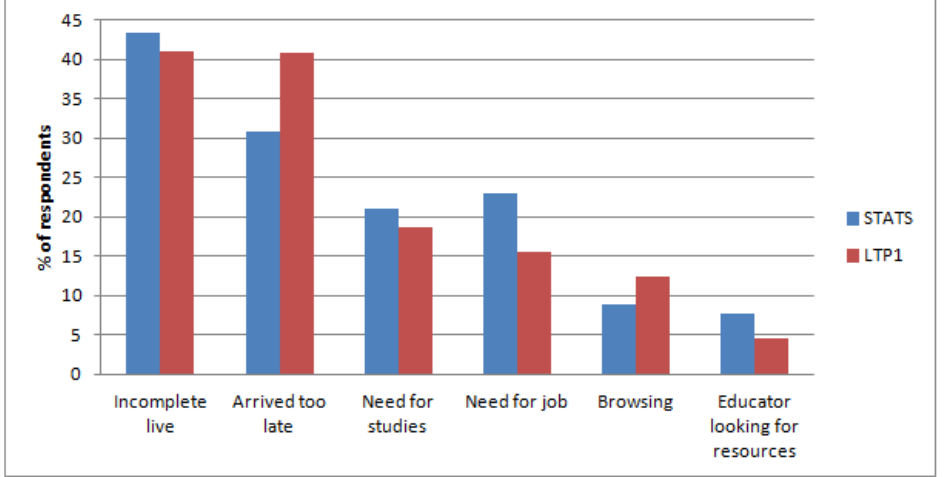
Figure 2. Reasons for enrolling in an archived MOOC.